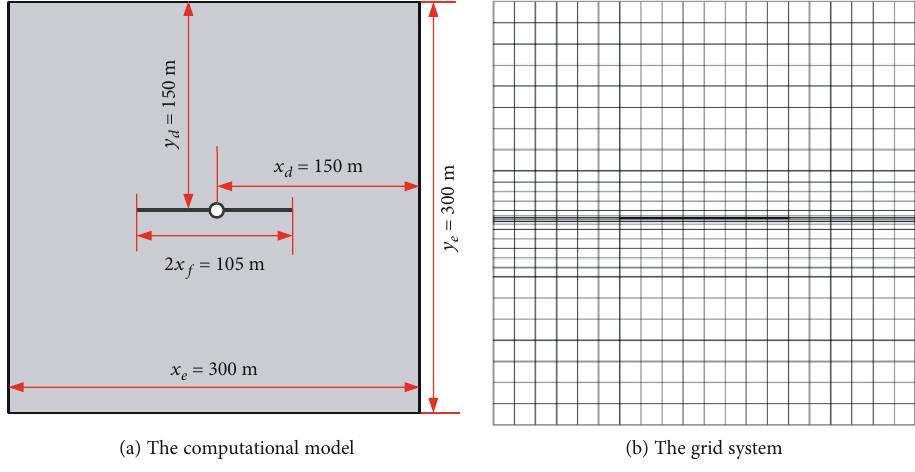
Figure 3: The scheme of the simulation